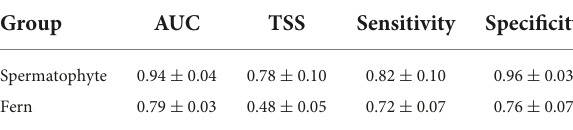
TABLE 3 AUC, TSS, sensitivity and specificity of Random Forest models predicting the probability that a tree is colonized by epiphytic spermatophytes and ferns in a lowland tropical rain forest (Xishuangbanna, Yunnan, SW